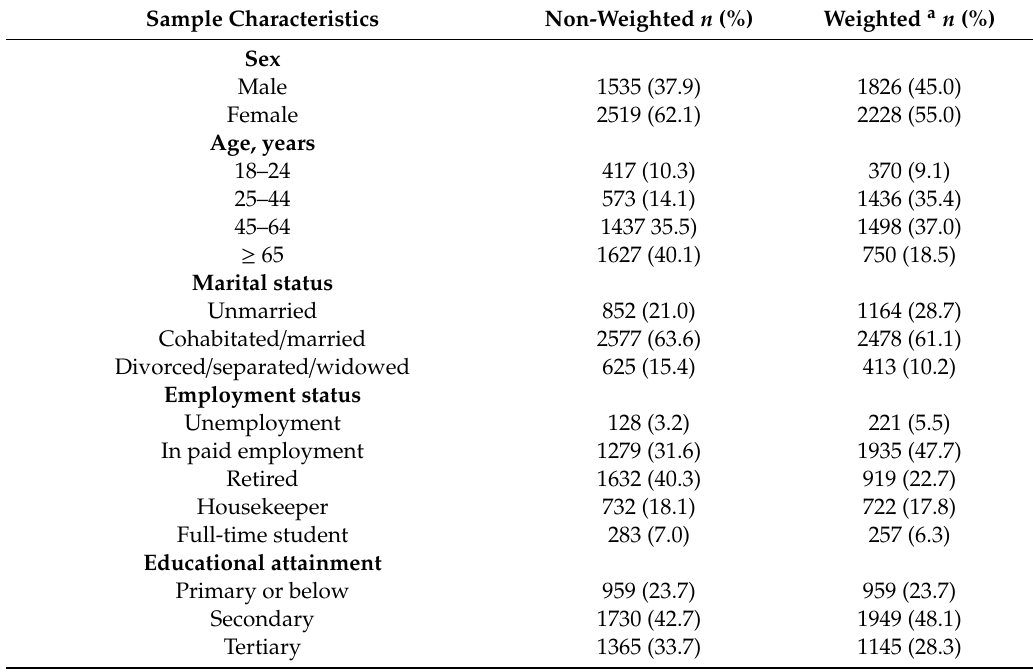
Table 1. Sociodemographic and lifestyle-related characteristics of the sample ( N =